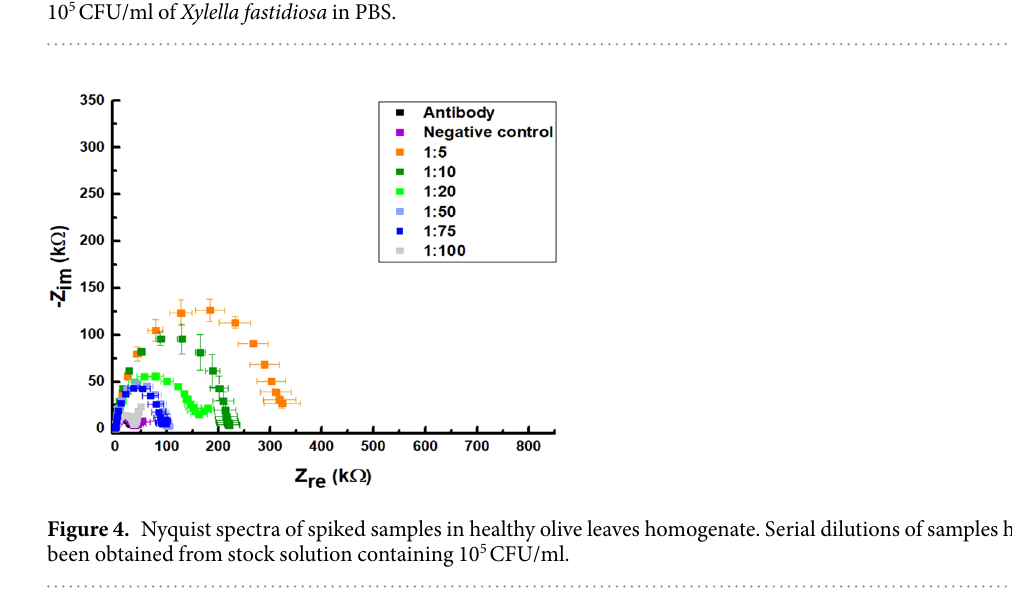
Figure 3. Nyquist spectra exemplifying the device response to serial dilution of stock solution (1:1) containing 10 5 CFU/ml of Xylella fastidiosa in PBS.